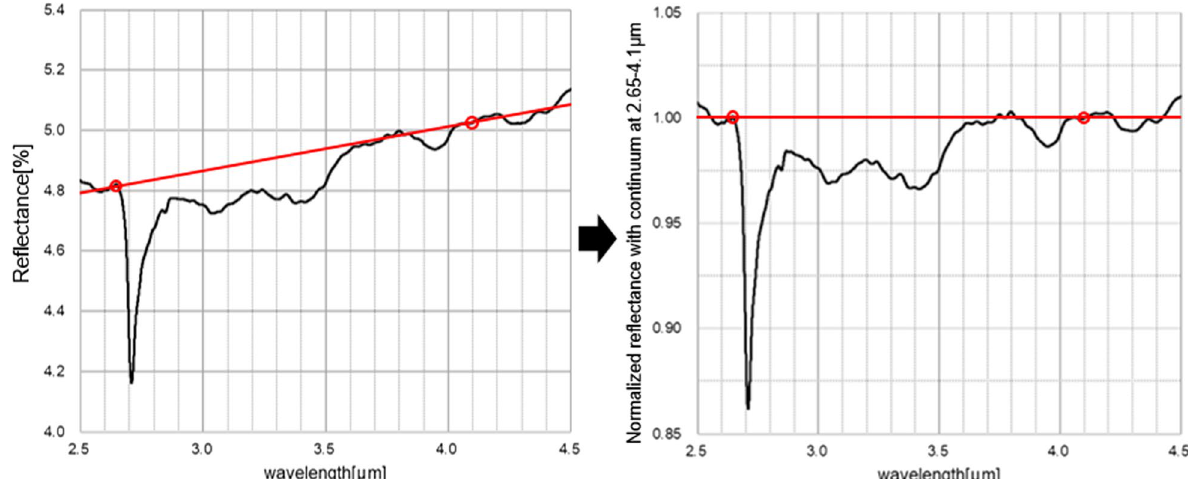
Fig. 7 Procedure to make reflectance spectrum with normalized to 2.65–4.1 μm continuum